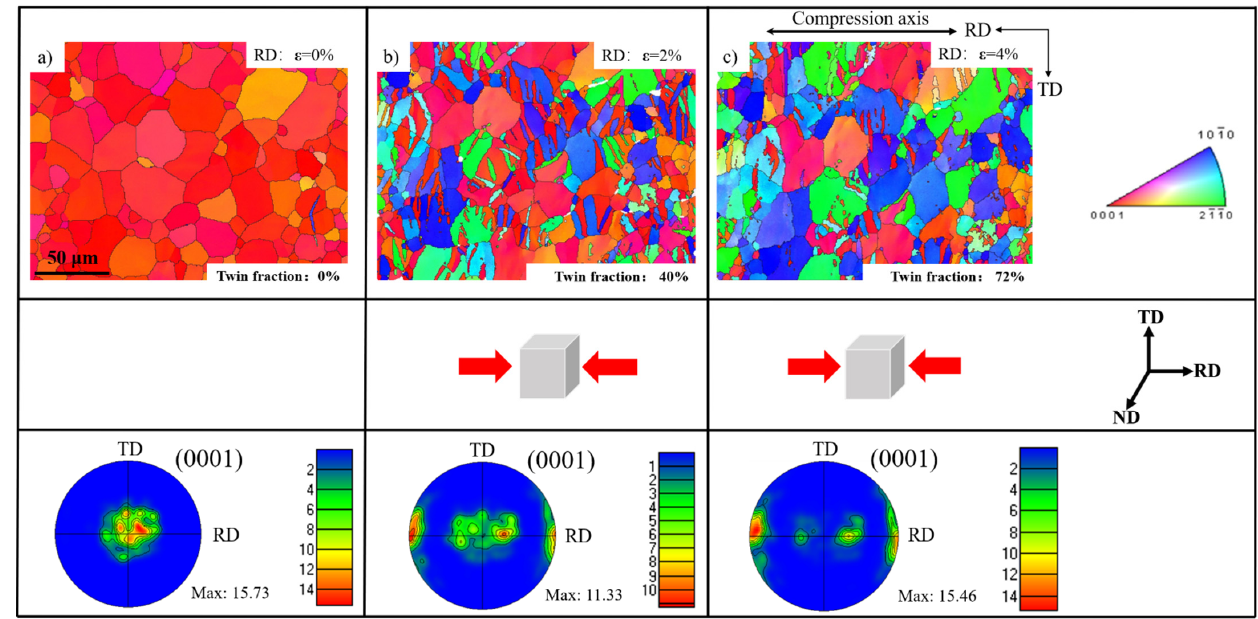
Figure 1. Microstructures and corresponding pole figures at strains of 0% ( a ), 2% ( b ), and 4% ( c ). Different from the uniaxial compression, the strain path change test was conducted on the second specimen. As presented in Figure 2, this sample was first compressed to 1.5% along the RD and then followed by the TD compression to the strain of 2%. First, the RD texture was observed in the pole figure after the first deformation, and then it decreased after the second compression along the TD. Meanwhile, the TD texture was generated. The maximum intensity of the basal texture decreased from 16.08 for the starting material to 11.00 after the first compression along the RD, and it continually decreased to 5.44 after the second deformation along the TD.